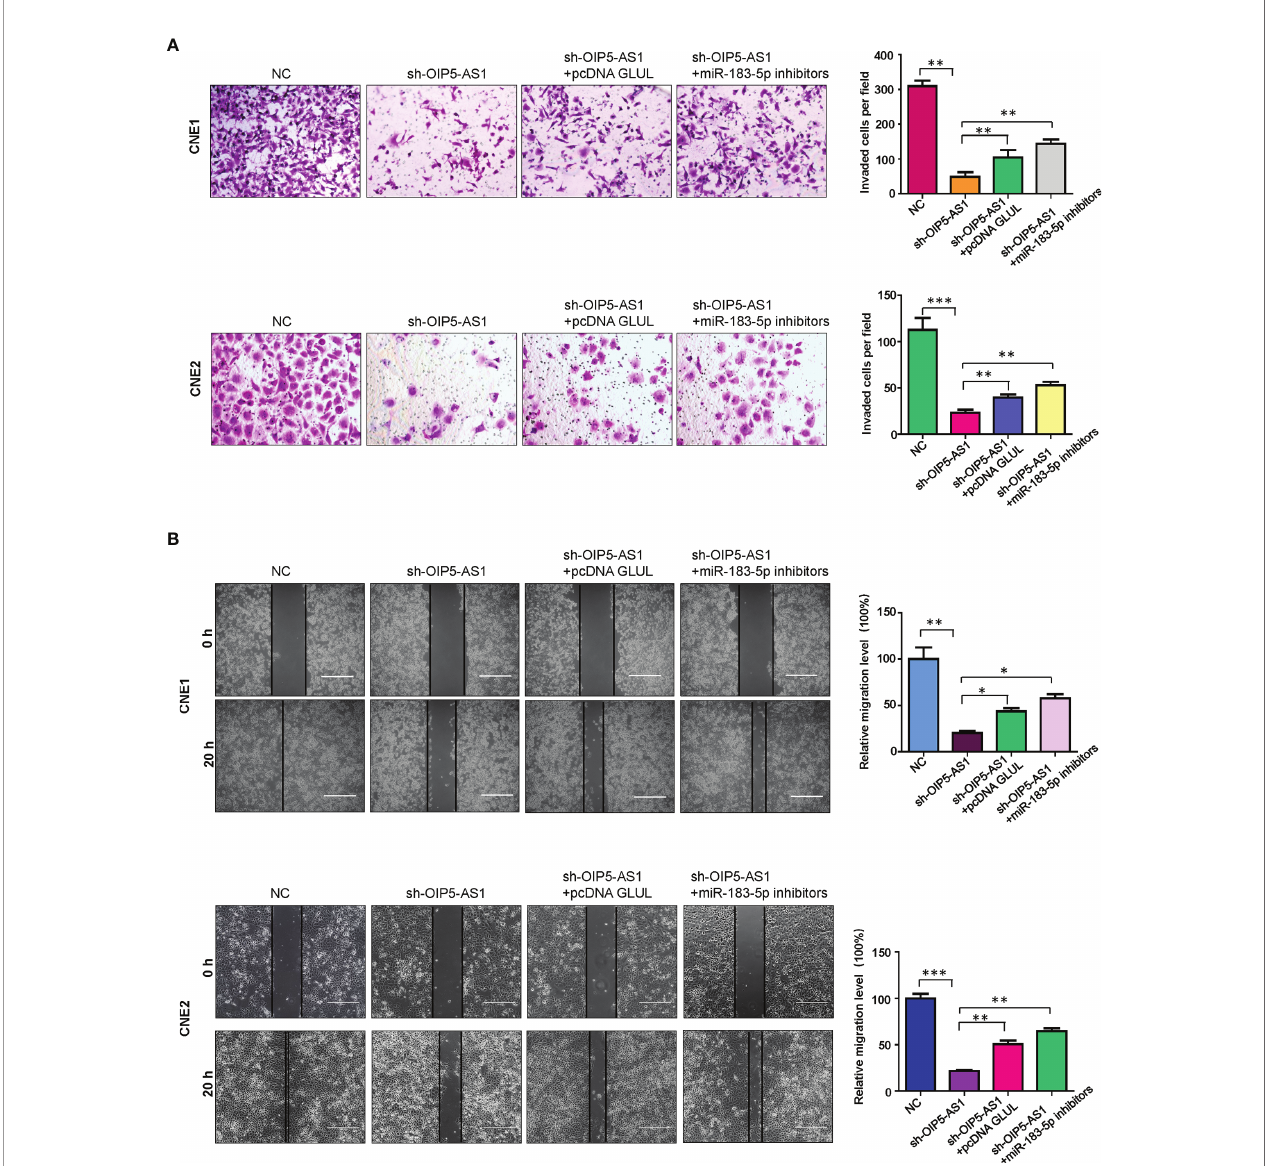
FIGURE 6 | OIP5-AS1 knockdown inhibits cell motility via regulating miR-183-5p and GLUL in NPC cells. (A), Transwell Matrigel invasion analysis was utilized to test the invasiveness capacity of NPC cells after OIP5-AS1 knockdown, GLUL overexpression and miR-183-5p downregulation. (Left panel). Quantitative data are represented (Right panel) * P<0.05 vs control; ** P<0.01; ***P<0.001. (B), Wound healing assays were utilized to measure the migratory activity of NPC cells after OIP5-AS1 knockdown, GLUL overexpression and miR-183-5p downregulation (Left panel). Quantitative data are represented (Right panel). *P<0.05; **P<0.01;